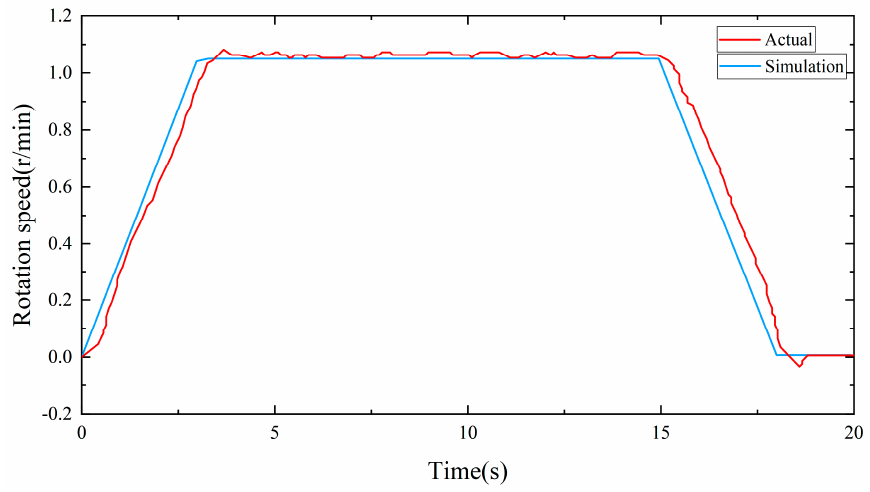
Figure 10. Comparison of rotation speed.